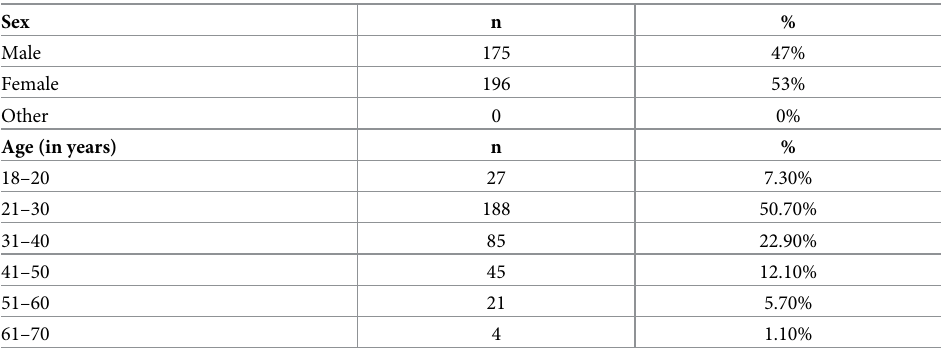
Table 7. Demographic data (n = 371) (Study 2).